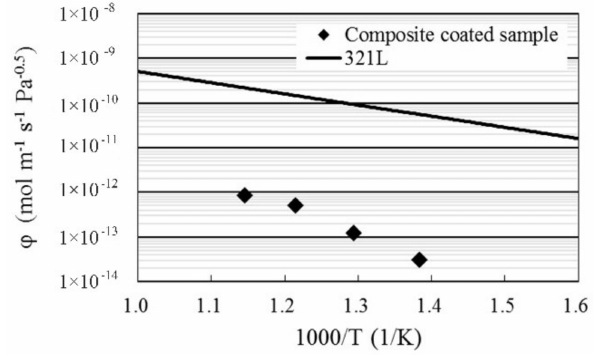
Figure 11. Deuterium permeabilities of the Cr 2 O 3 /Al 2 O 3 coated sample.